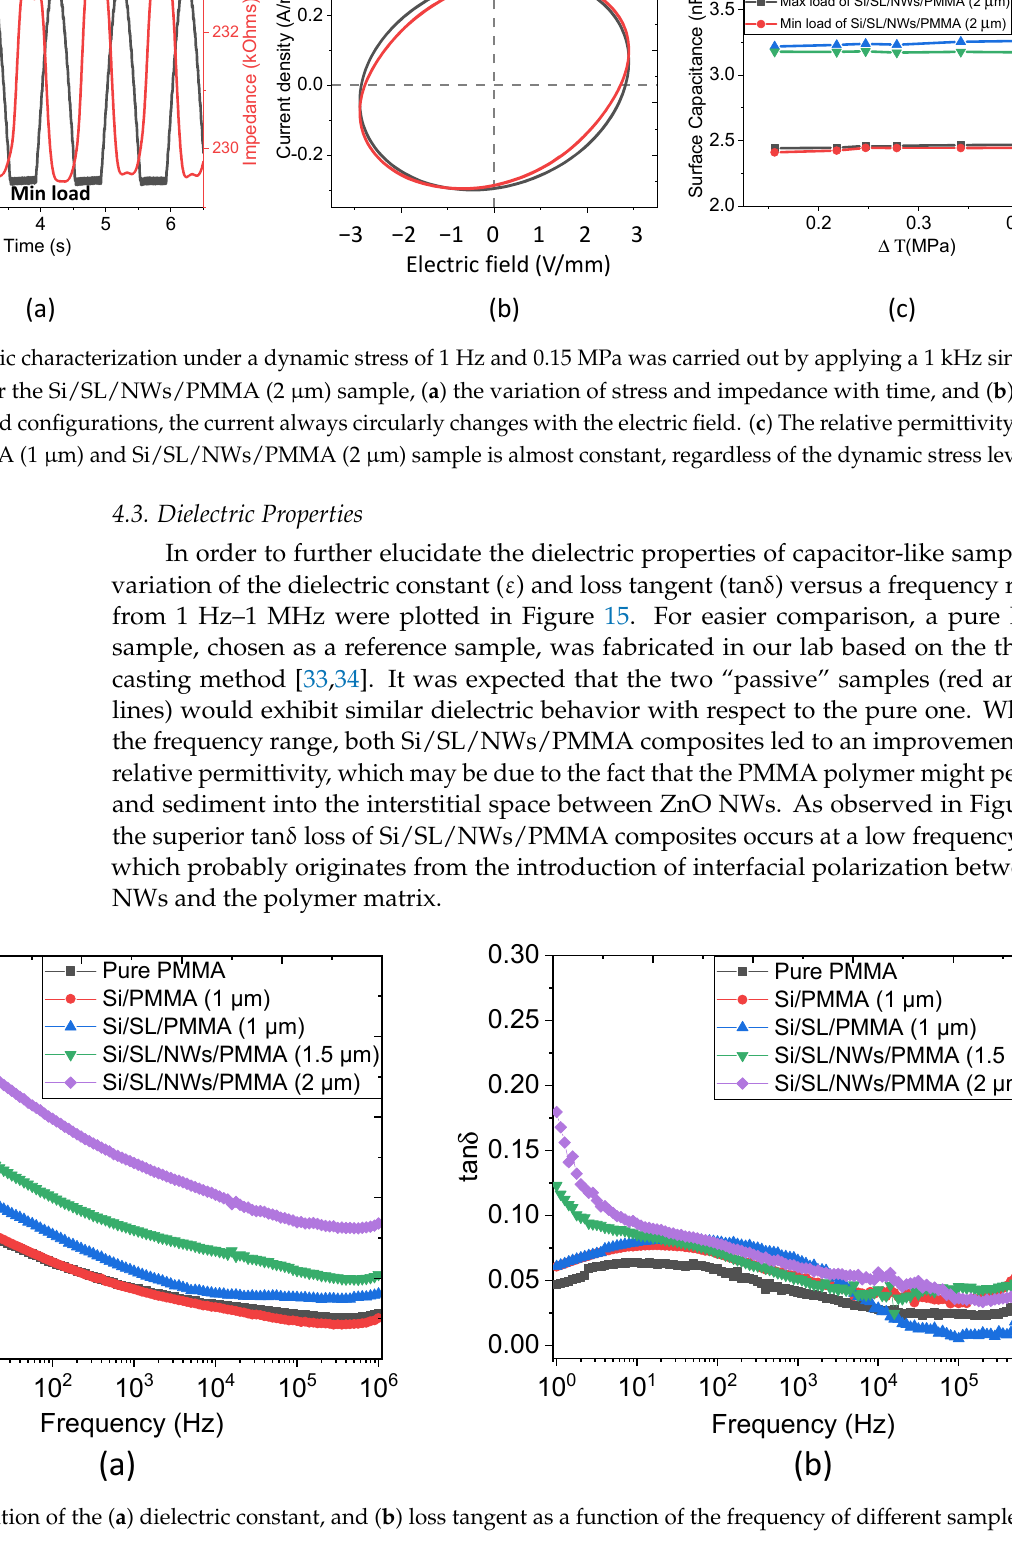
Figure 15. Variation of the ( a ) dielectric constant, and ( b ) loss tangent as a function of the frequency of different samples.